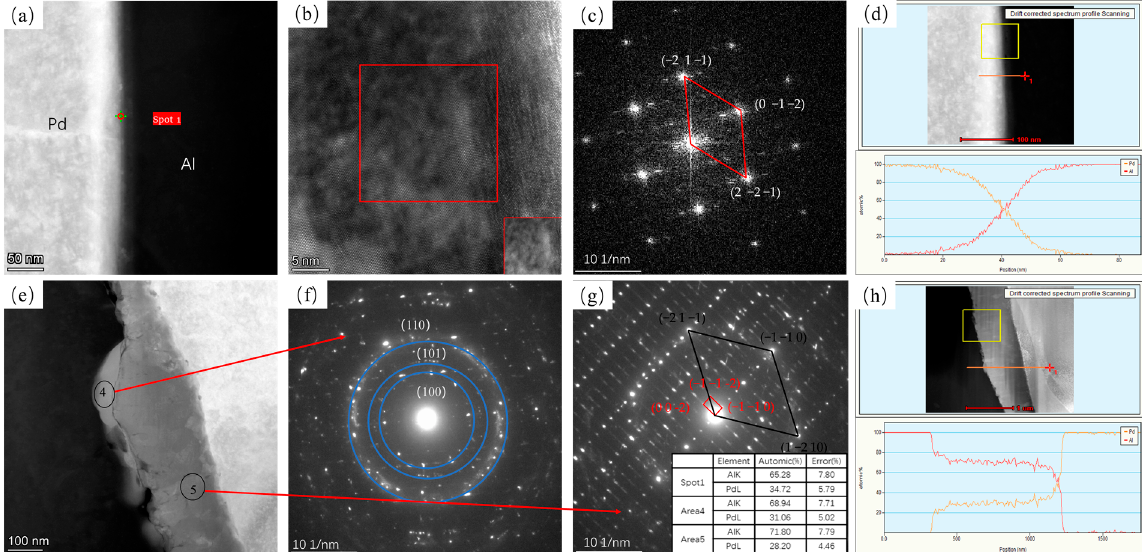
Figure 3. TEM plots of Pd/Al composite wires annealed at 200 °C for different times and their SEAD plots; ( a ) HAADF plot at 5 s, ( b ) high-resolution plot of spot 1 in ( a , c ) FFT transform of the red region in ( b , d ) EDS line sweep at 5 s, ( e ) HAADF plot at 1080 s, ( f ) SAED plot of spot 4 in ( e , g ) SAED plot of spot 5 in ( e ) and EDS results for each position, and ( h ) EDS line sweep at 10,800 s.